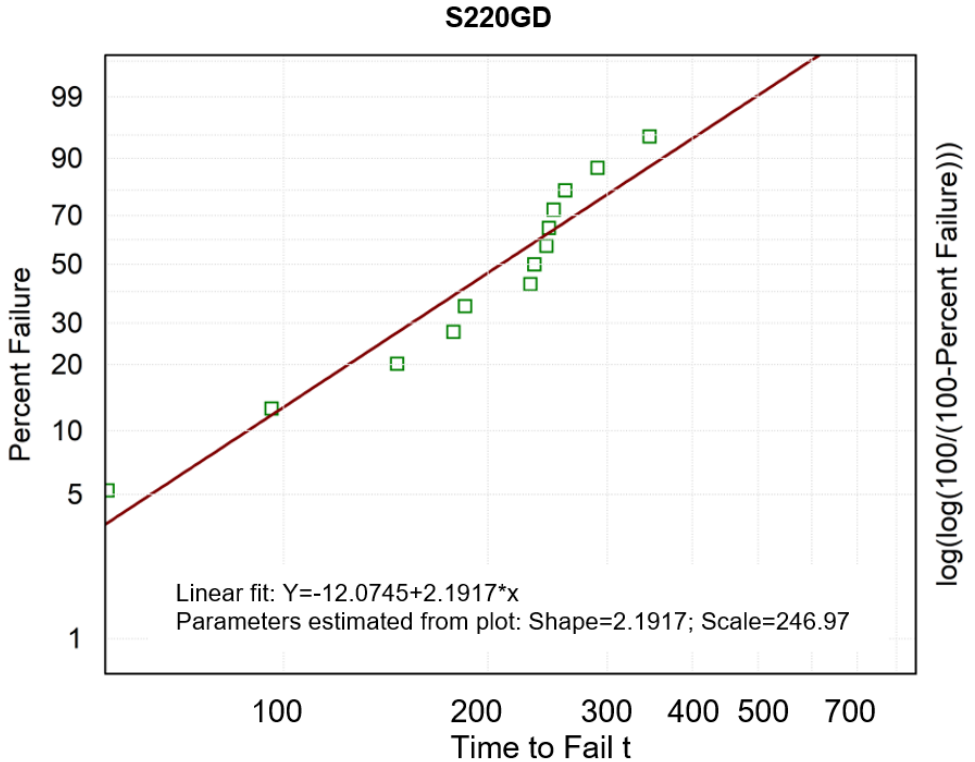
Figure 12. Weibull probability distribution for the wear of the S220 GD coating.